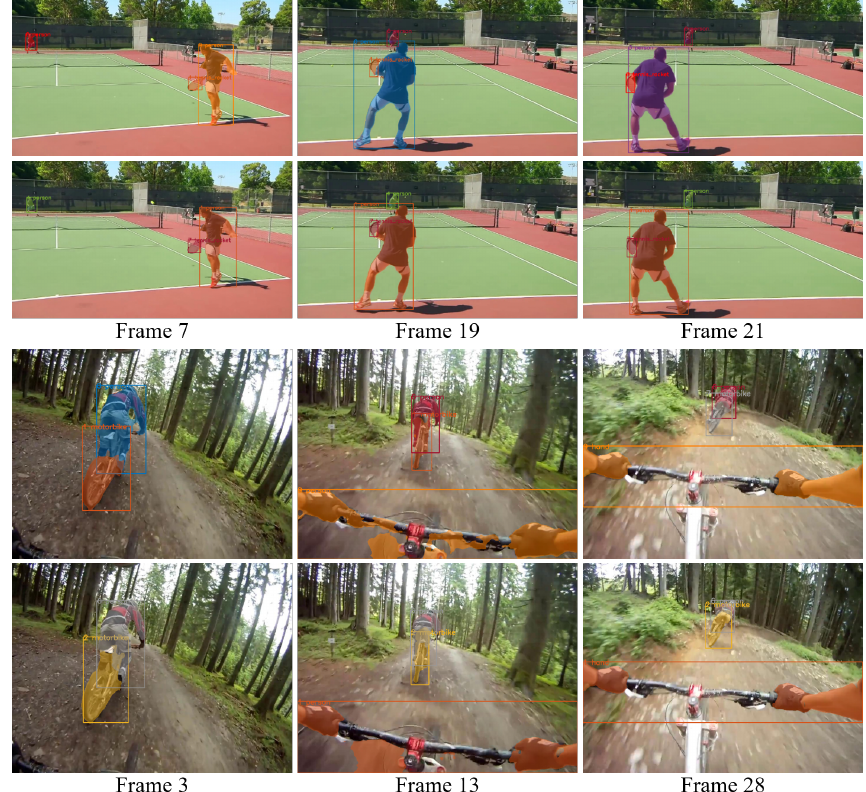
Figure 2. Result comparison between our method and the baseline DETR. At each frame, the upper result is conducted by DETR, the lower is our solution. The same color represents predictions from the same query slot. In the first line, as the person and the tennis racket move from the right side to the left in camera. DETR detects them with different query slots. In the second line, the size of the person changes between different frames. DETR uses different queries to detect him. However, in our framework, despite the spatial and size changes, the same instance is detected in the same query